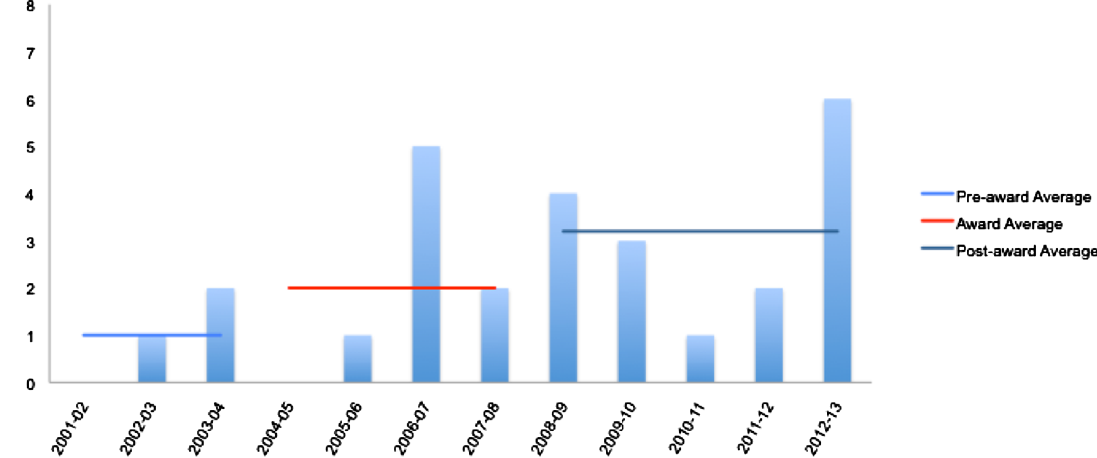
FIG. 4. PhysTEC secondary graduates from the University of Colorado, Boulder (CU-B).